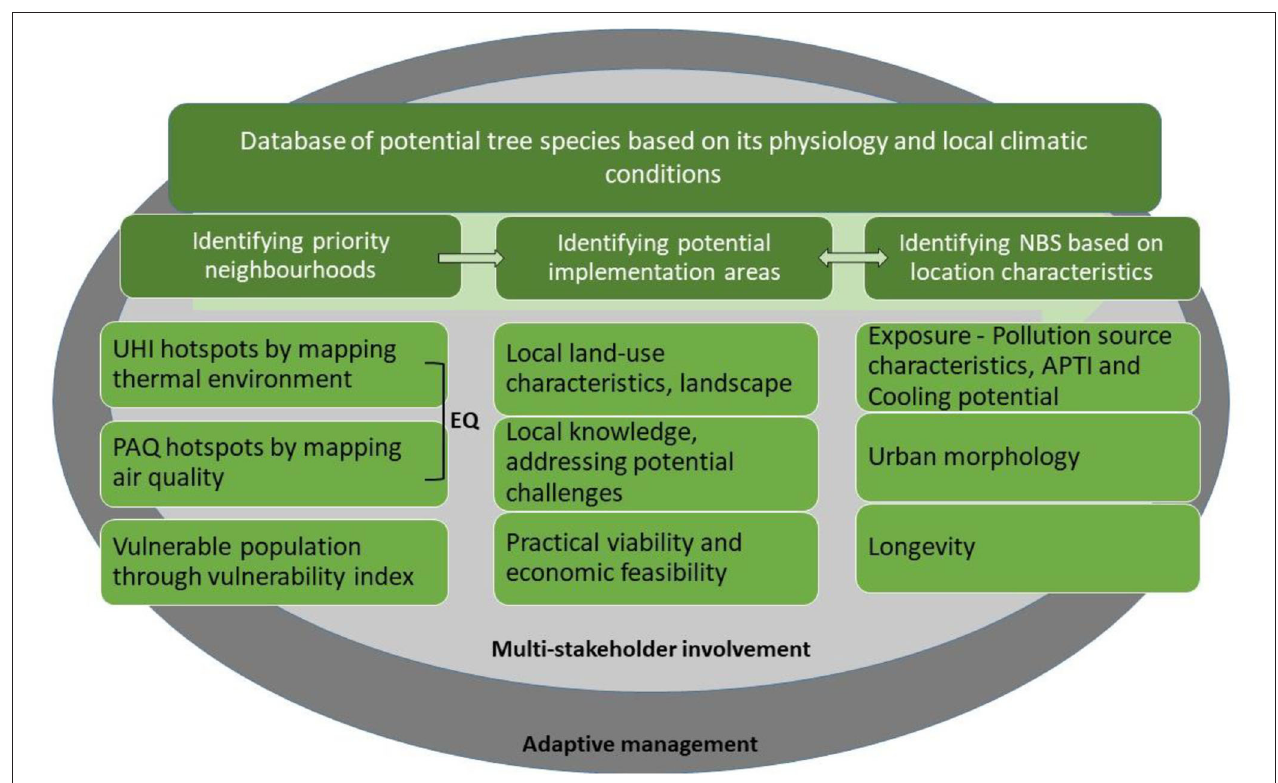
FIGURE 2 | Technical framework for NbS design in urban areas for co-mitigation of air pollution and urban heat (EQ- Environmental